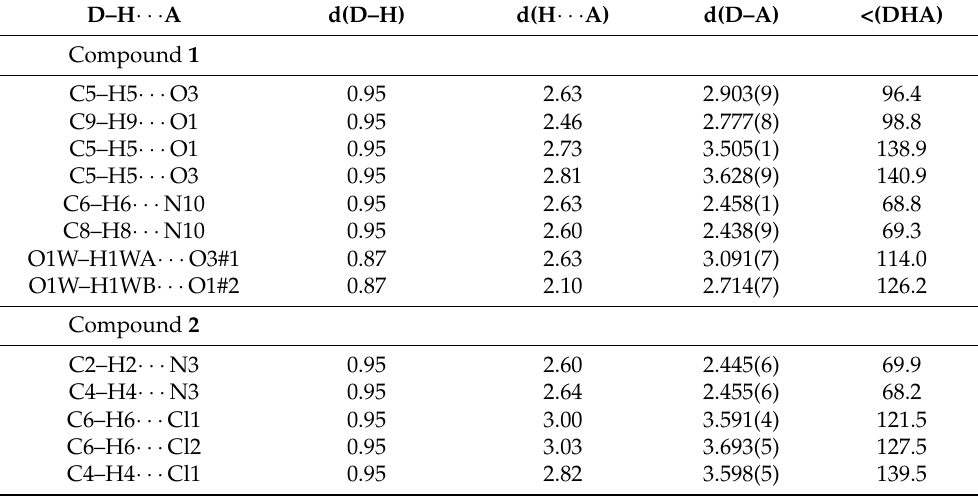
Table 3. Selected parameters for hydrogen bonding interactions in compounds 1 and 2